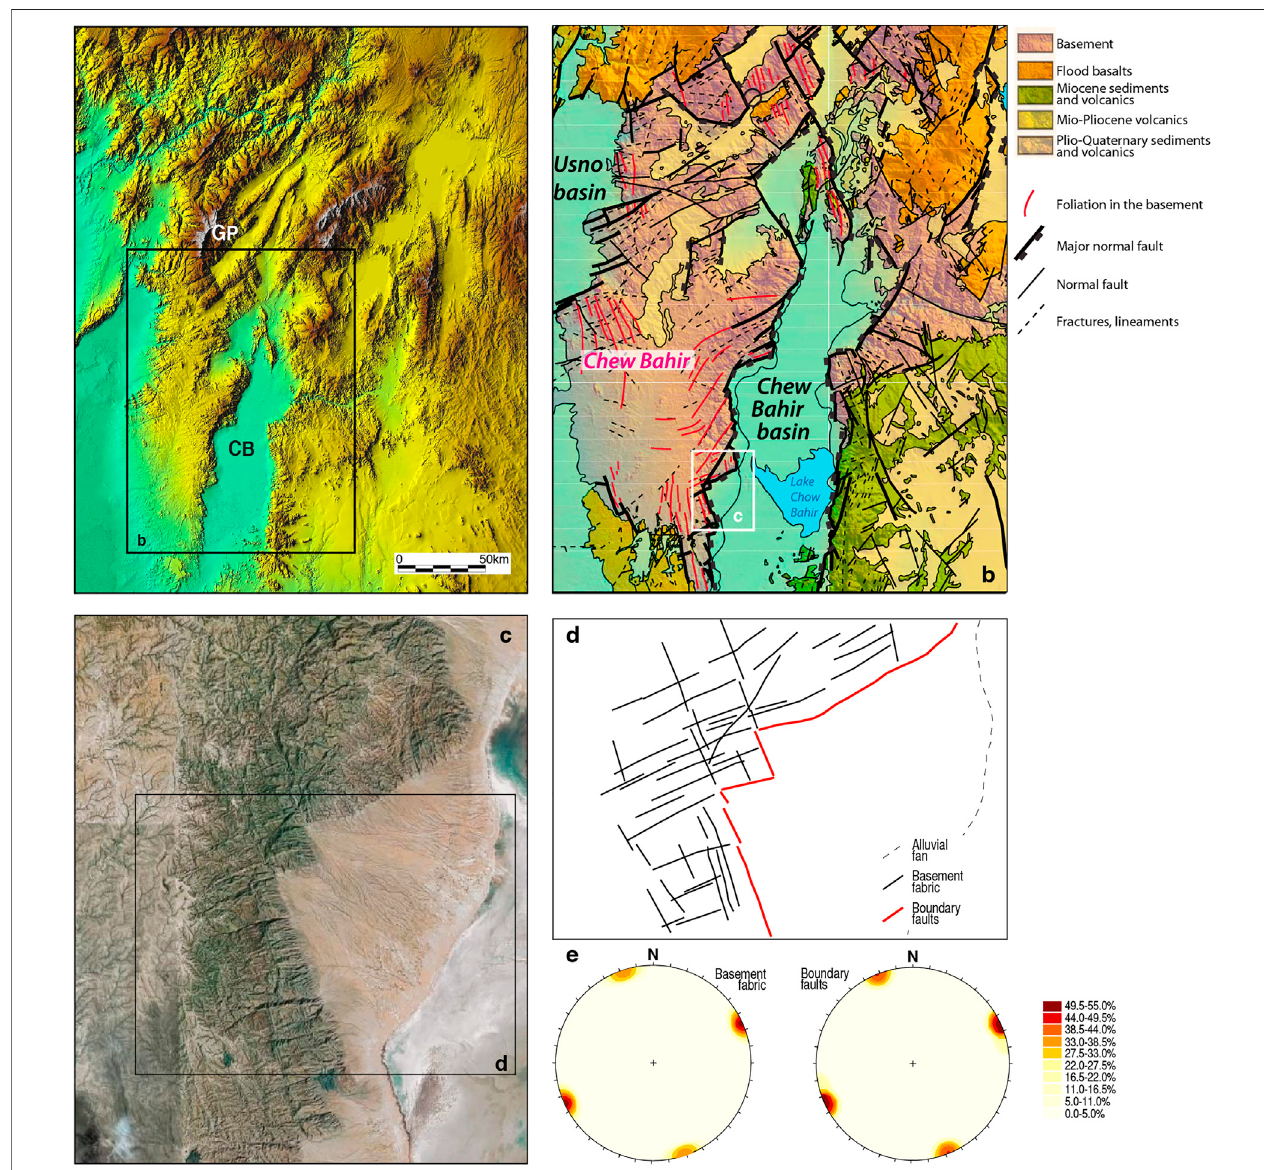
FIGURE 7 | (A) Digital elevation model (NASA-SRTM) of southern Ethiopia. CB: Chew Bahir; GP: Gofa province. (B) Geological map of the Chew Bahir basin and surrounding areas, illustrating the pattern of foliation on the basement. (C) Typical angular pattern of boundary faults of the Chow Bahir basin (see text for details); (D) structuralsketch. (E) Distributionofinheritedbasementfabricsandboundaryfaults,illustratedasplotsofweightedfaultazimuths.Notethesimilaritybetweenthetrendof basement fabrics and that of boundary faults, supporting that the development of the latter is strongly in fl uenced by basement inherited weaknesses. Panels (A) , (C) , (D) , (E) modi fi ed from Corti (2009); panel (B) modi fi ed from Philippon et al. (2014).